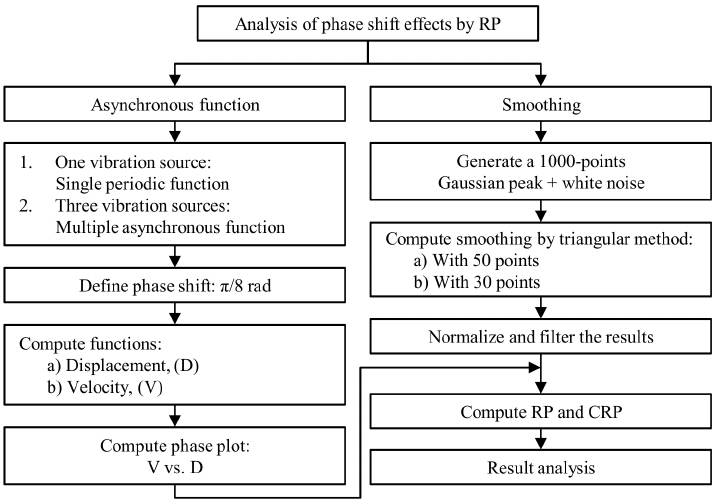
Figure 2. Proposed flow chart to analyze the phase shift effects on functions and